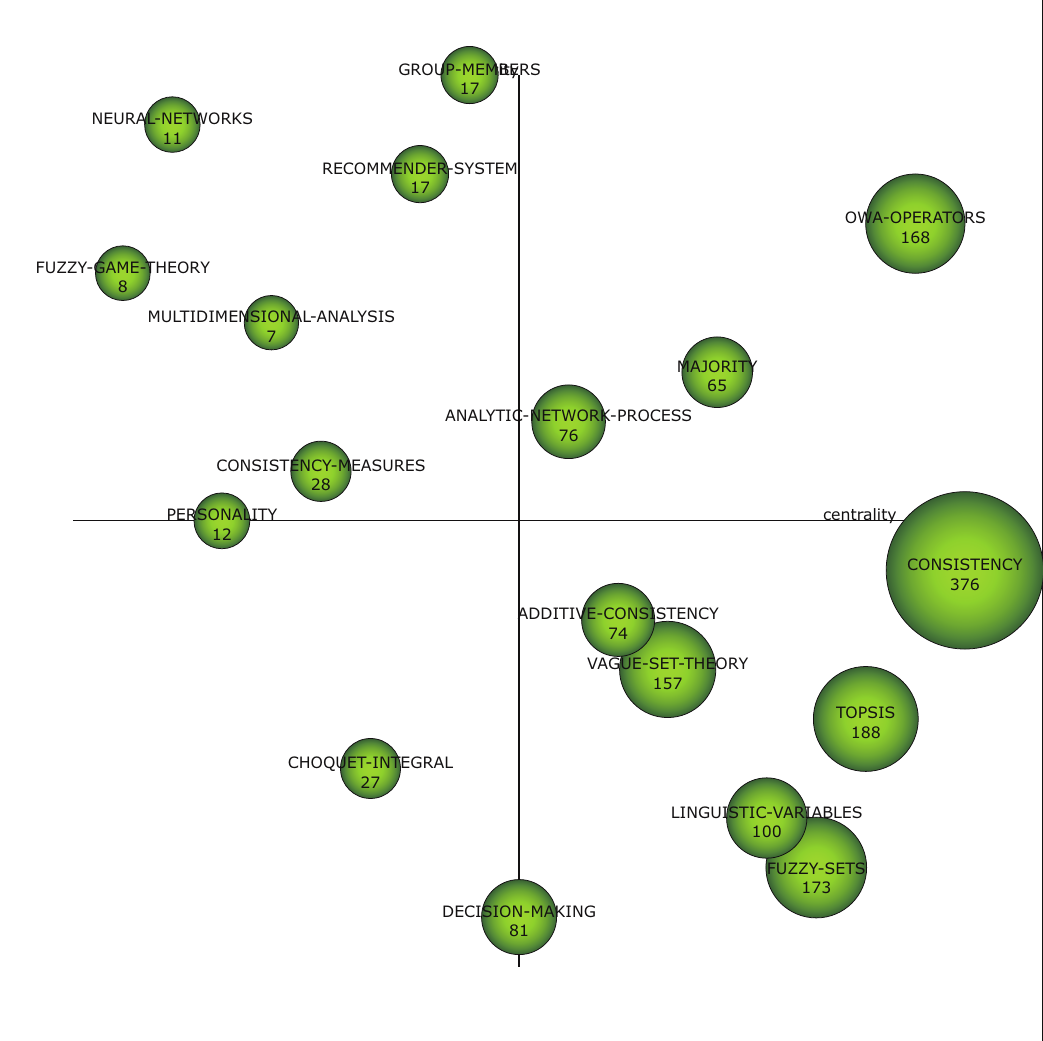
Figure 13. Strategic diagram for the 2010–2014